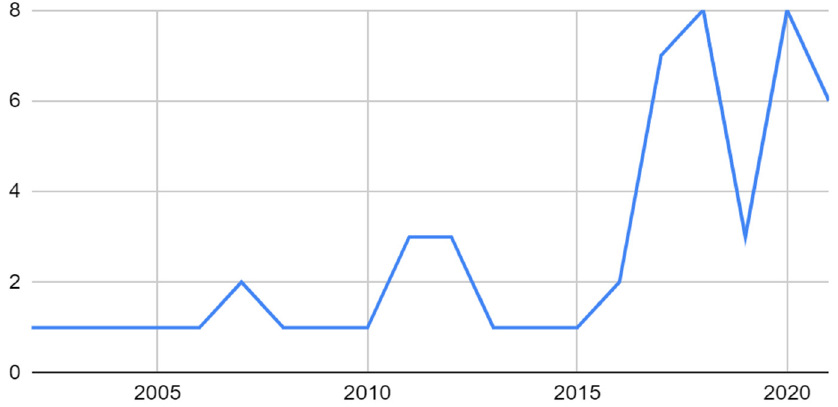
Figure 2. Annual publications.